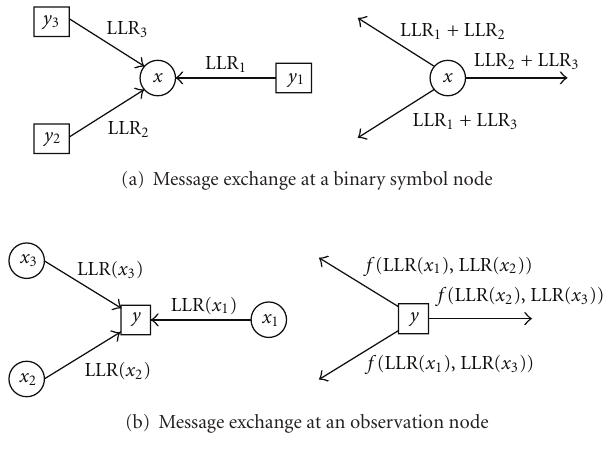
Figure 4: Message exchange at di ff erent